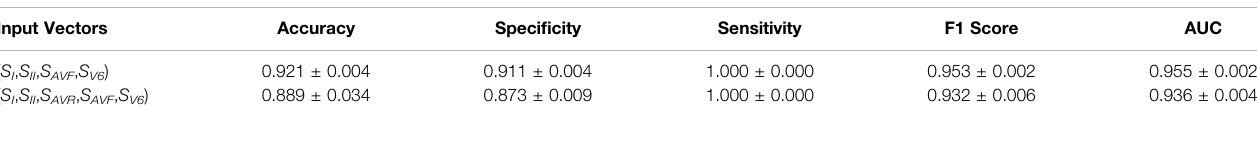
TABLE 2 | Results of feature selection using the grid search for the ECG-only model on the training